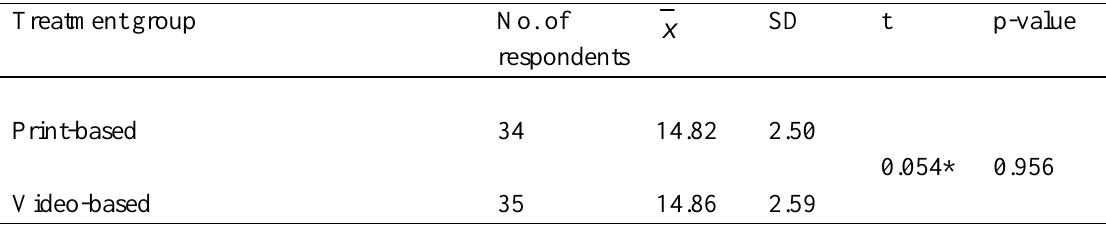
x SD t p-value respondents 0.054* 0.956